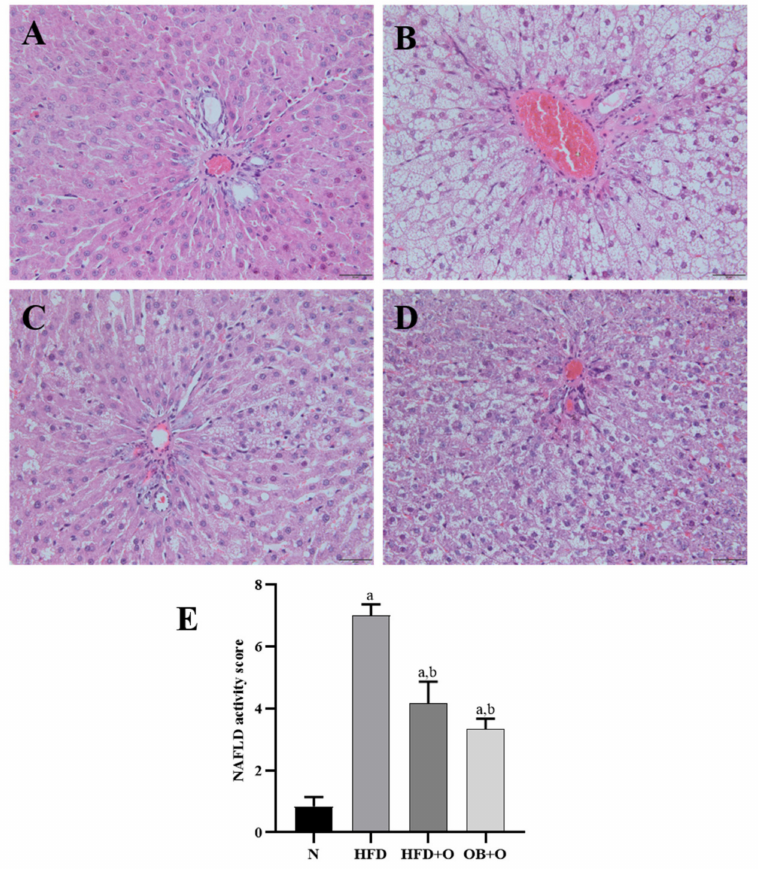
Figure 7. ( A – E ). Photomicrographs of the liver using hematoxylin and eosin staining. N, normal control; HFD, high-fat diet; HFD + O, high-fat diet + orlistat 10 mg/kg/day (protective model); OB + O, obese+orlistat 10 mg/kg/day (therapeutic model). ( A ) The N group shows normal liver architecture. ( B ) The HFD group shows severe hepatic steatosis and marked inflammatory cells around the portal triad. ( C , D ) The HFD + O and OB + O groups show reduction of fat deposition and inflammation. (H&E, magnification, × 400). ( E ) NAFLD activity score in all groups. Data are expressed as mean ± SEM, n = 6/group. One-way ANOVA, followed by Tukey post-hoc test. a p < 0.05 vs. Normal group, b p < 0.05 vs. HFD